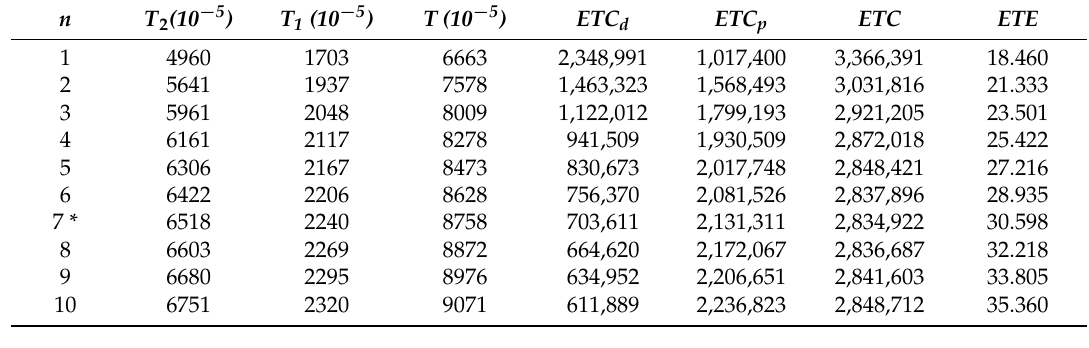
Table 3. Expected total cost for different n in Model 1.